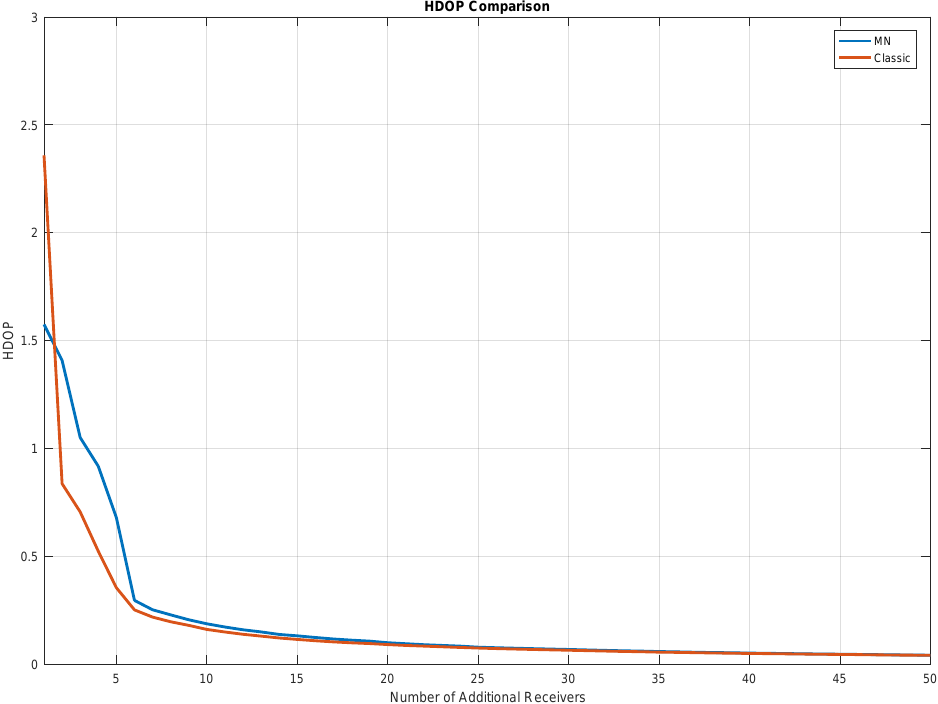
Figure 8. Comparison between traditional (red) and MN TDOA (blue) algorithms in terms of Horizontal DOP (HDOP) as a function of the number of additional receivers.